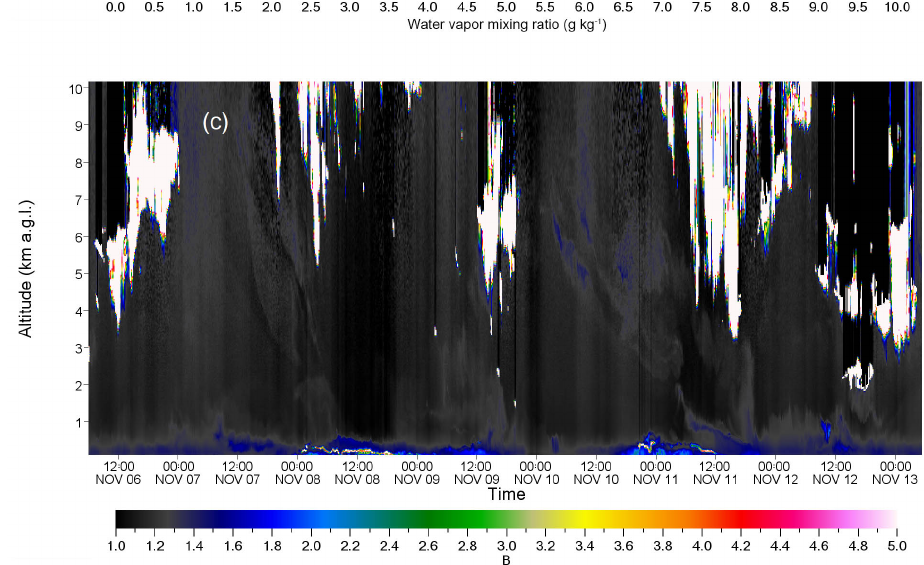
Figure 9. False-color plots the first 10km of the atmosphere for (a) ozone, (b) water vapor and (c) aerosol backscatter ratio for the period of 6–13 November 2016 at the Oski-ôtin ground